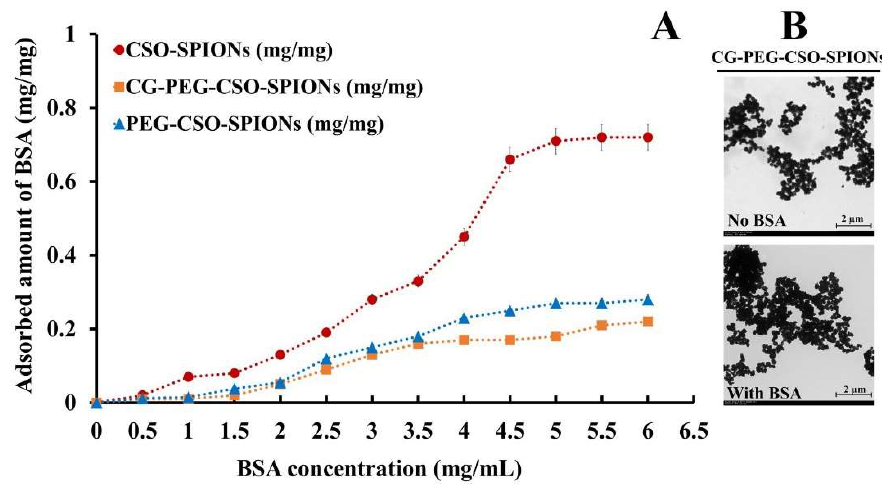
Figure 9. In vitro protein (BSA) binding onto the ( A ) CSO-SPIONs; PEG-CSO-SPIONs; CG-PEG-CSO-SPIONs, and ( B ) a representative TEM image of the CG-PEG-CSO-SPIONs before and after incubation with the BSA solution.